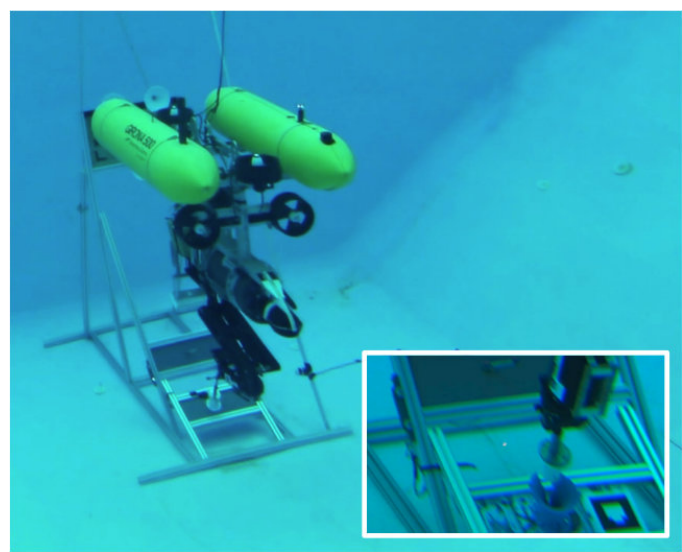
Figure 7. Girona 500 I-AUV docked in a subsea panel unplugging a hot stab connector in a water